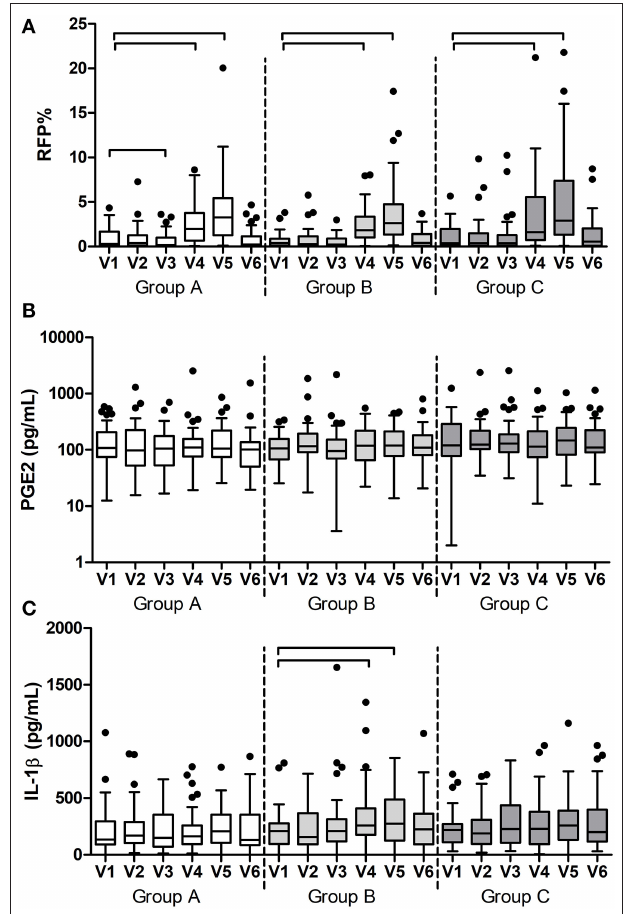
FIGURE 4 | Results of the additional measurements per group and visit: (A) prevalence of red fluorescing plaque (RFP%); (B) concentration of prostaglandin E2 (PGE2) and (C) concentration of interleukin-1ß (IL-1ß) in saliva. The connectors connect the visits that differed significantly ( P < 0.05, Wilcoxon Signed Ranks test) from the baseline